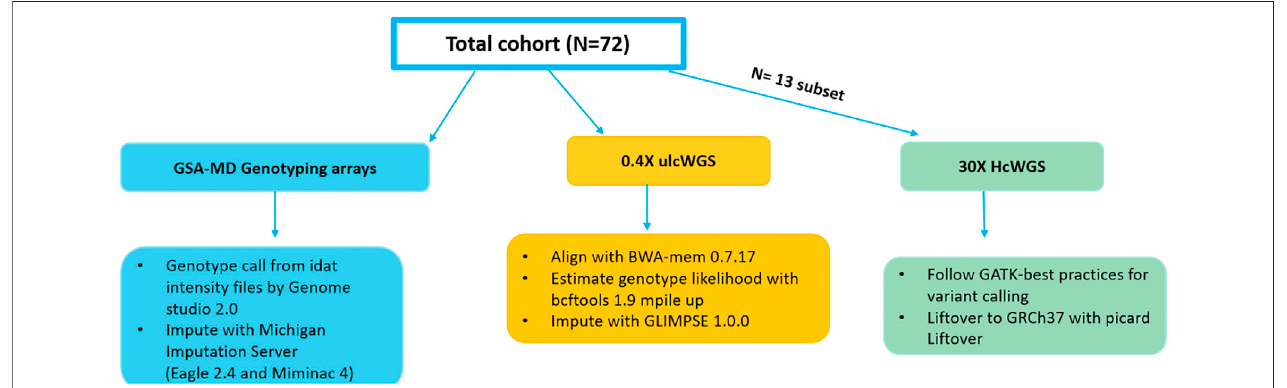
FIGURE 1 | Schematic work fl ows of the study design and analytical pipelines. The total 72 individuals of European descent in the study were genotyped with In fi nium Global Screening Multi-Disease Array (GSA-MD) (V2.0/V3.0) and whole-genome sequenced to a target 0.4 × coverage. A subset of 13 samples had high- coverage whole-genome sequencing (WGS) (30X) data available and were used to conduct a secondary analysis to assess ultra low-coverage whole-genome sequencing (ulcWGS) performances against genotyping-based